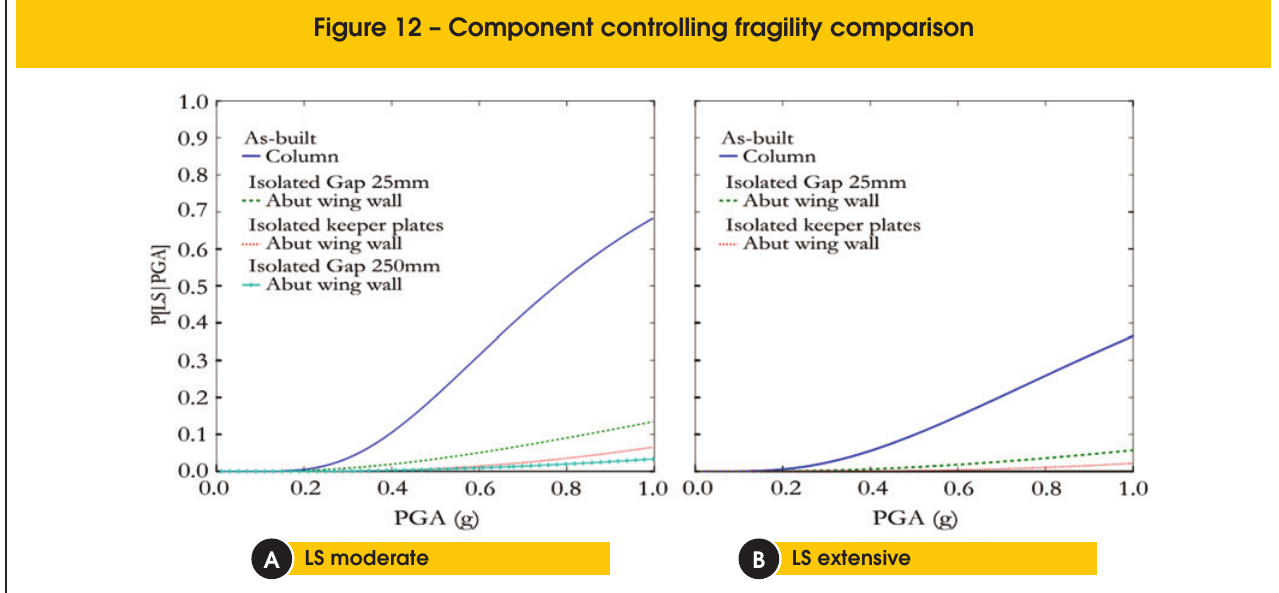
Figure 12 – Component controlling fragility